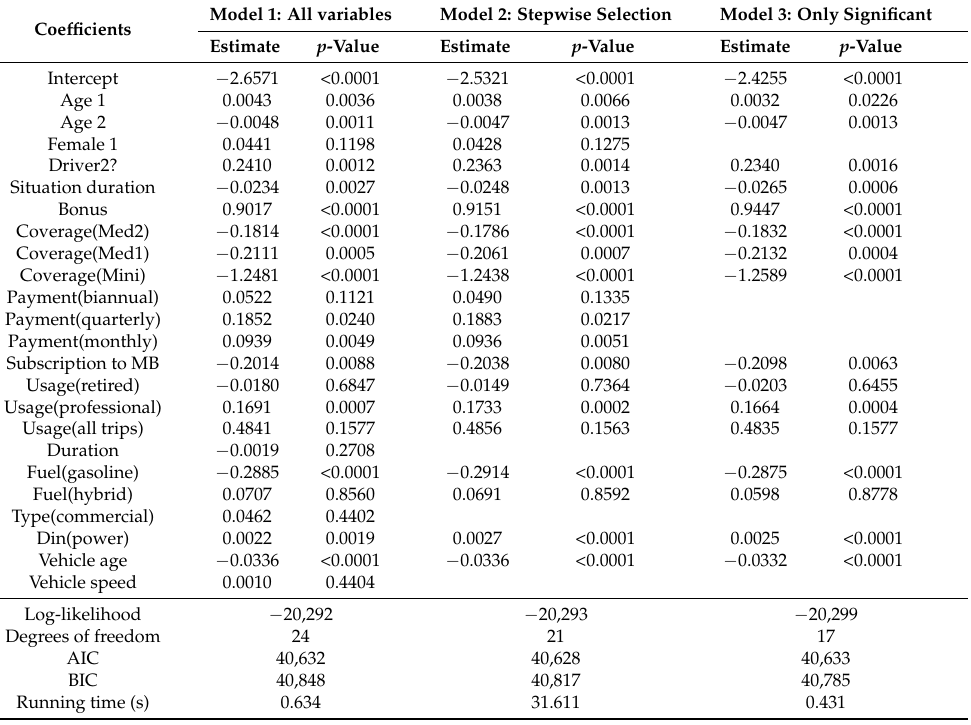
Table 5. Regression coefficients of logistic